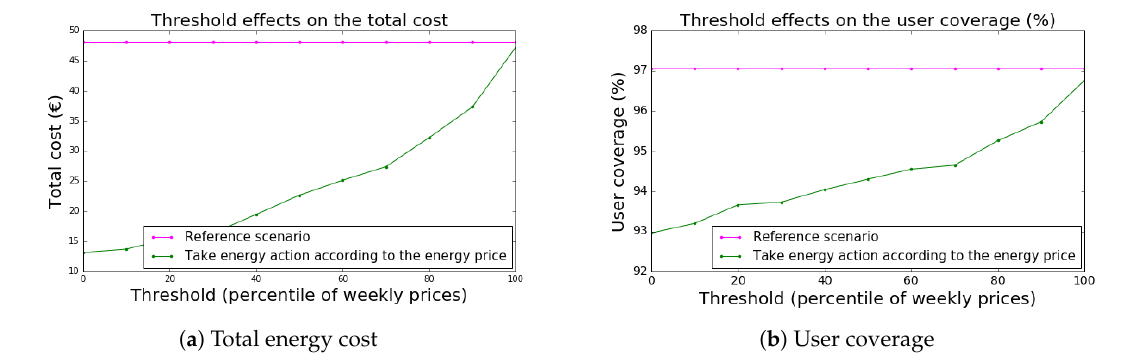
Figure 14. Take action according to the energy price: effects of threshold variation on the total energy cost ( a ) and the user coverage ( b ).